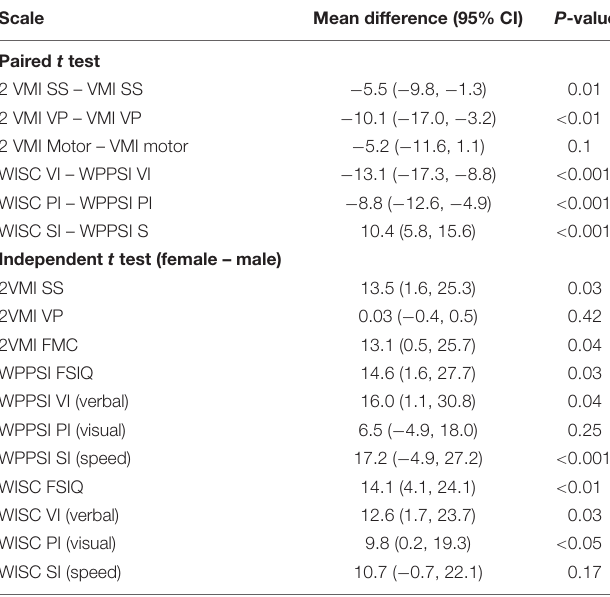
TABLE 4 | Results of the paired and independent t tests of the Swedish cohort. Scale Mean difference (95% CI) P -value